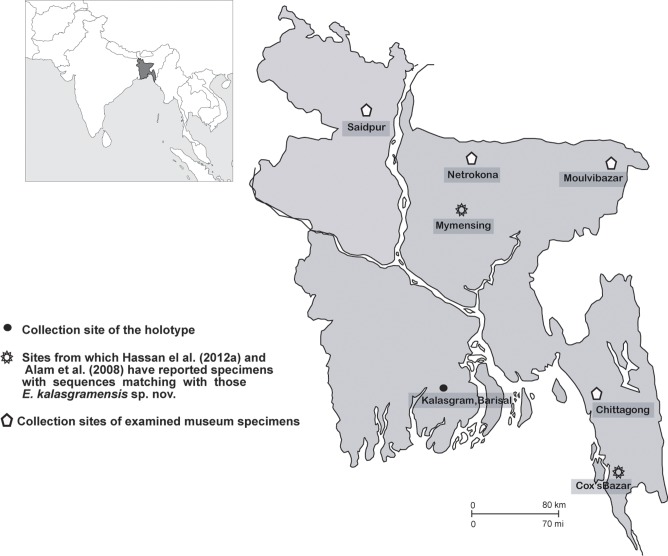
A map showing localities from where Euphlyctis kalasgramensis sp. nov. has been encountered.